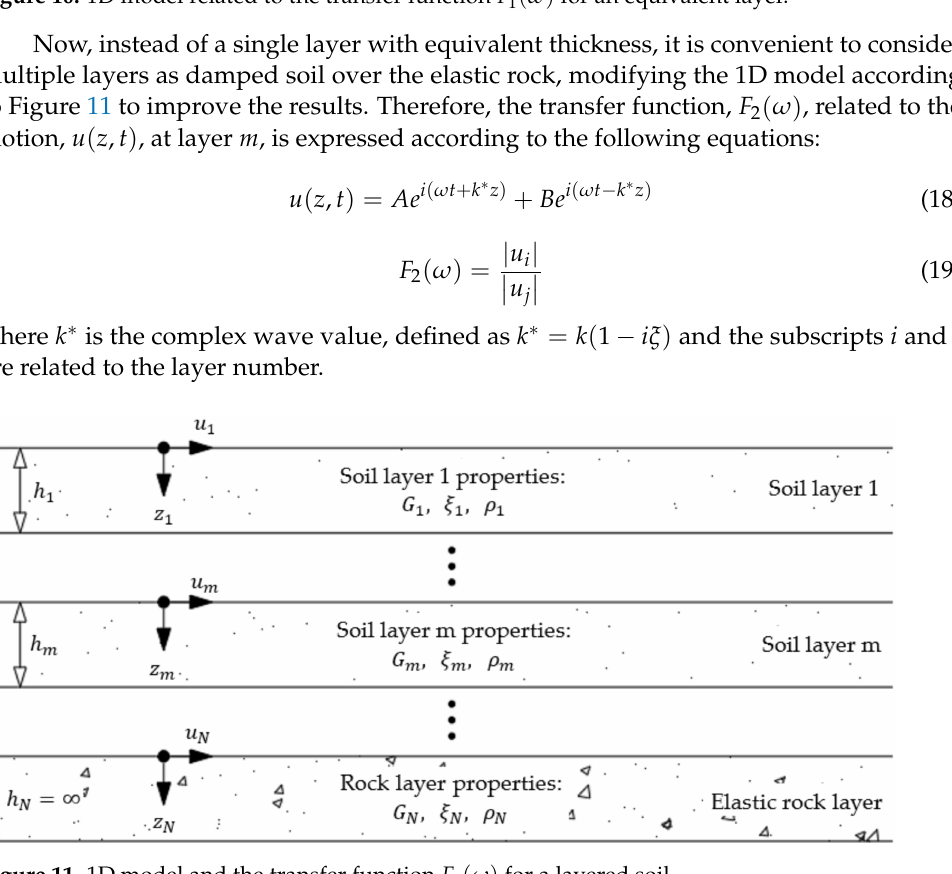
Figure 10. 1D model related to the transfer function F 1 ( ω ) for an equivalent layer.